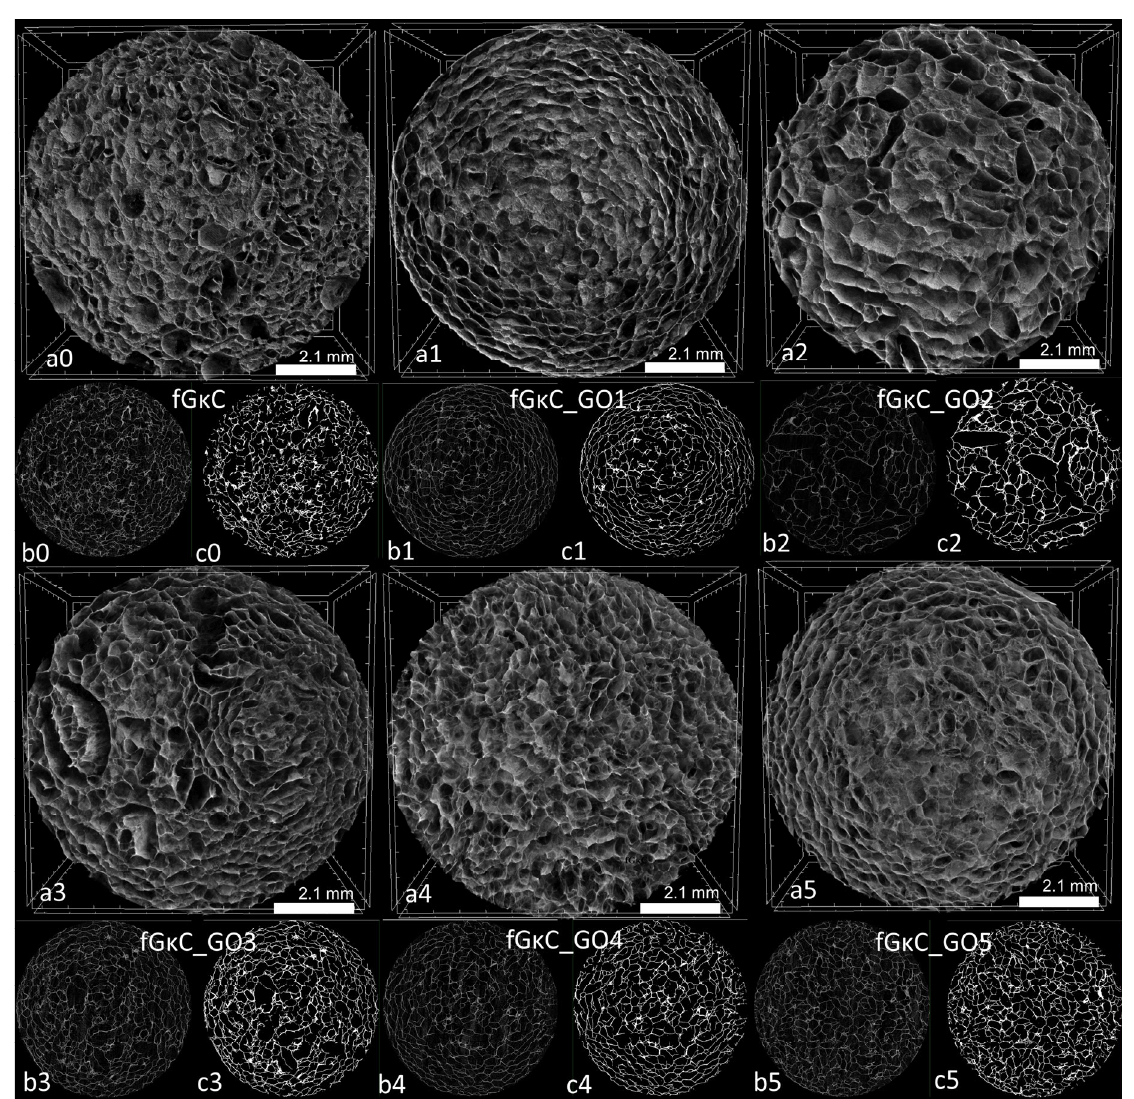
Figure 3. Cross-sectional captures of reconstructed tomograms illustrated in CTVox ( a0 – a5 ) and relevant slices exported from CTAn before ( b0 – b5 ) and after ( c0 – c5 ) the binarization step.